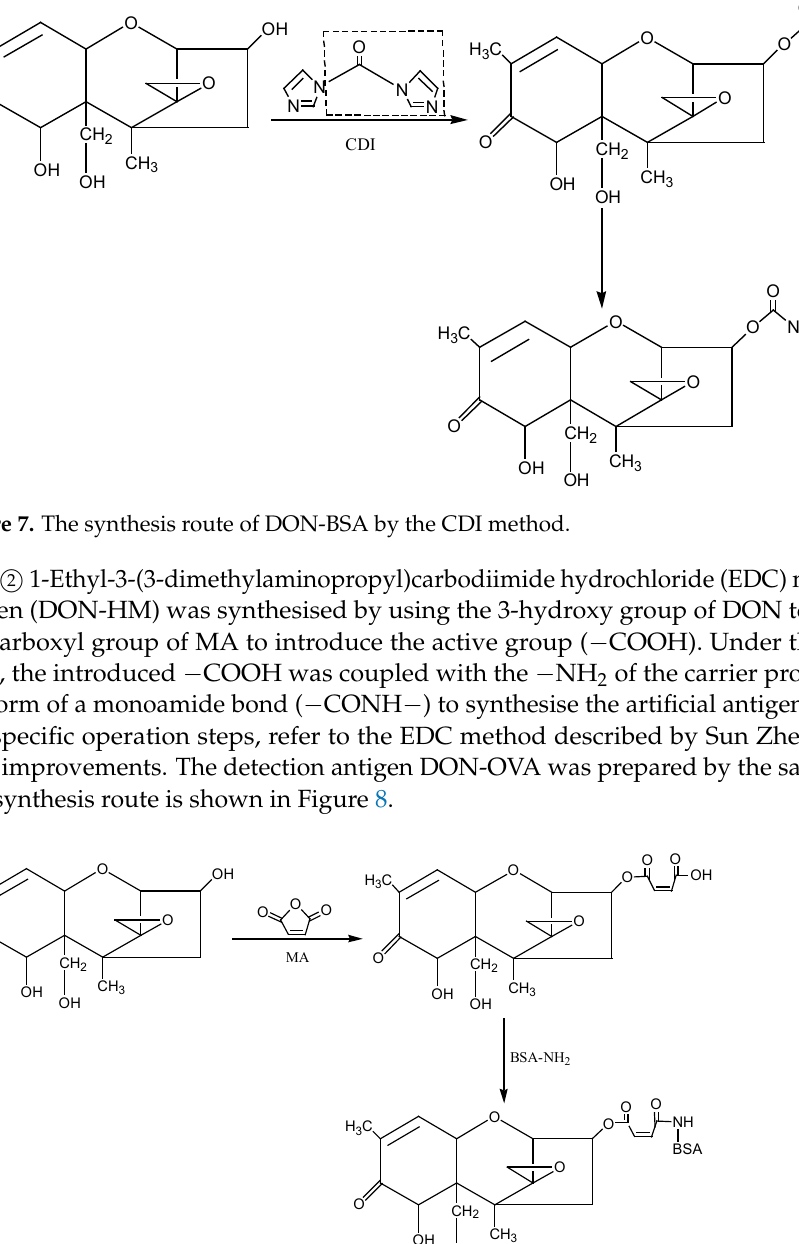
Figure 9. The synthesis route of DON - BSA by the IBCF method. ④ N- hydroxysuccinimide (NHS) method: According to the molecular structure of DON, the hydroxyl groups ( − OH) at the 7th and 15th positions of DON were first blocked with 1 - butylboronic acid, and then the hydroxyl group at the 3rd position of DON was reacted with glutaric anhydride (GA) to introduce the active group ( − COOH) to form the semiester compound DON - HG. Under the action of NHS and EDC, the artificial antigen